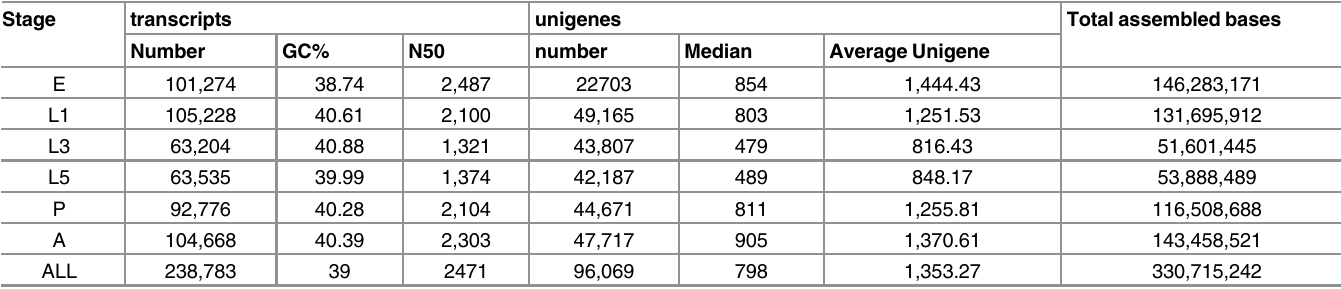
Table 1. Summary for Pieris rapae developmental